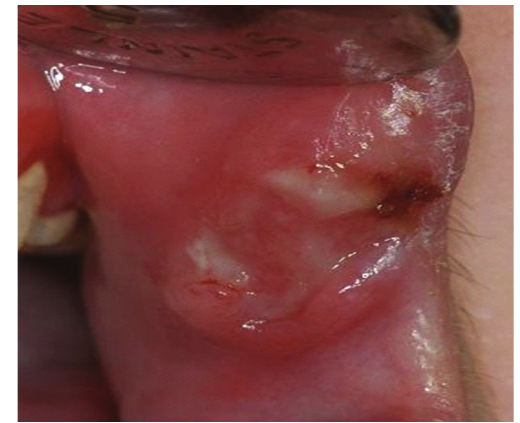
Figure 2: Ulceration of labial commissural.